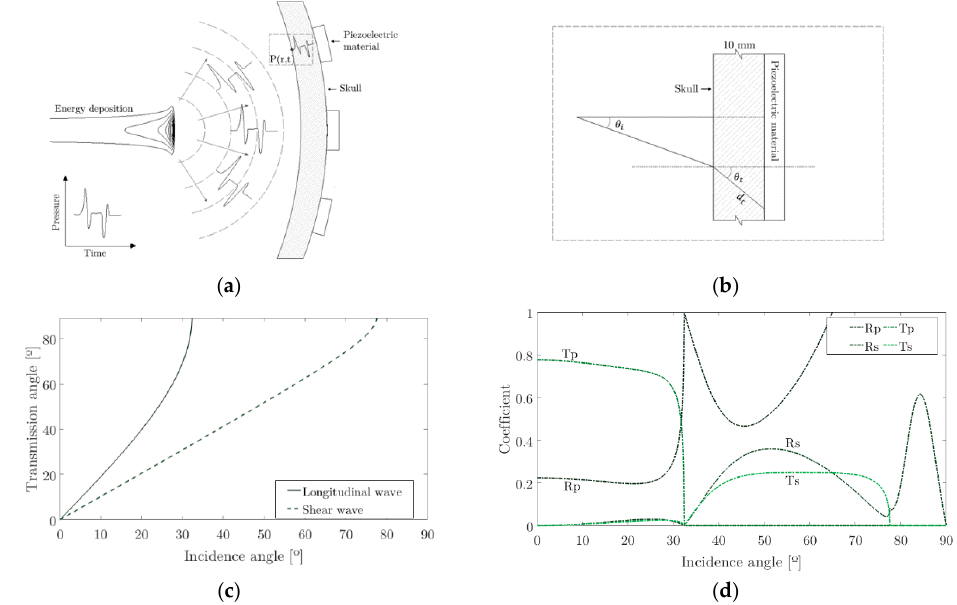
Figure 6. ( a ) Propagation of a longitudinal wave to the point P ( r , t ) where the speed of sound changes due to the change of medium; ( b ) general diagram of the incidence and transmission angle in the skull; ( c ) transmission angle for longitudinal and shear waves in terms of the incidence angle; ( d ) power transmission and reception coefficients of the cerebrospinal fluid-skull interface.